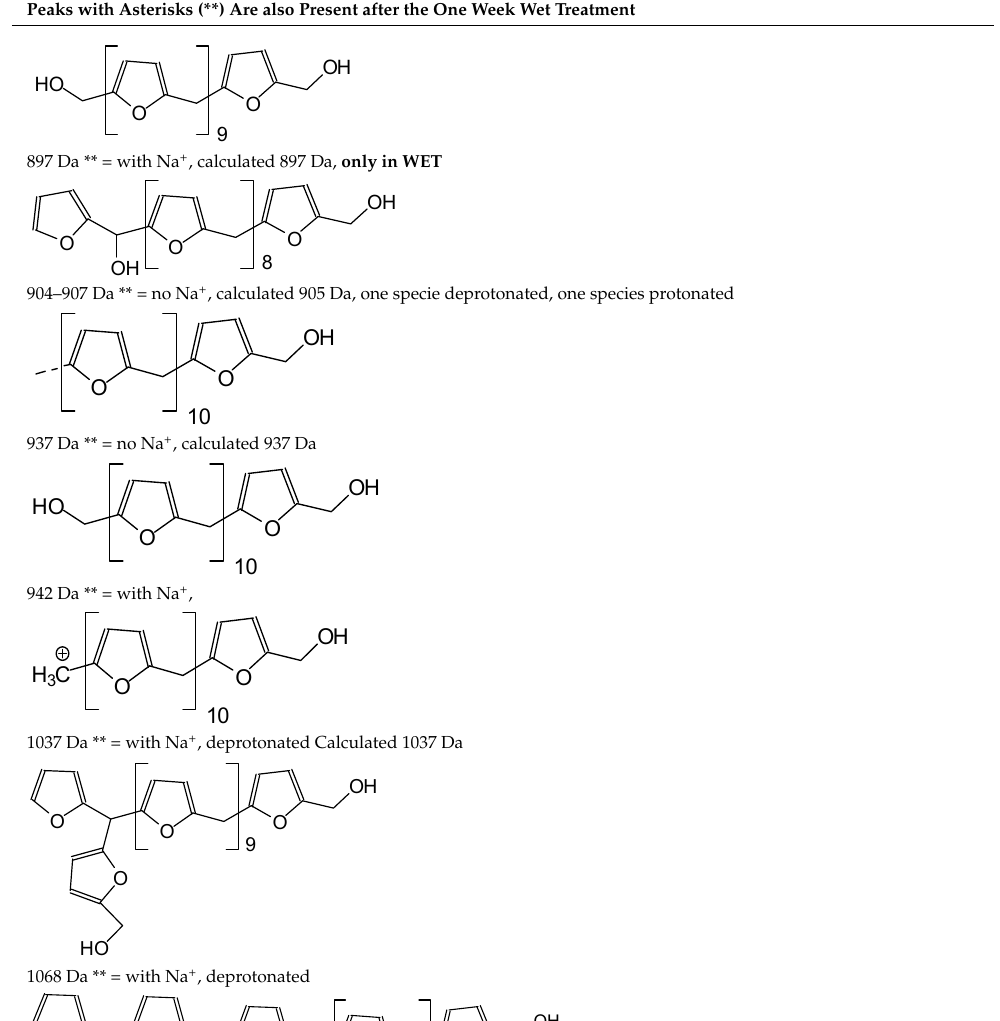
Table 1. Cont. Peaks with Asterisks (**) Are also Present after the One Week Wet